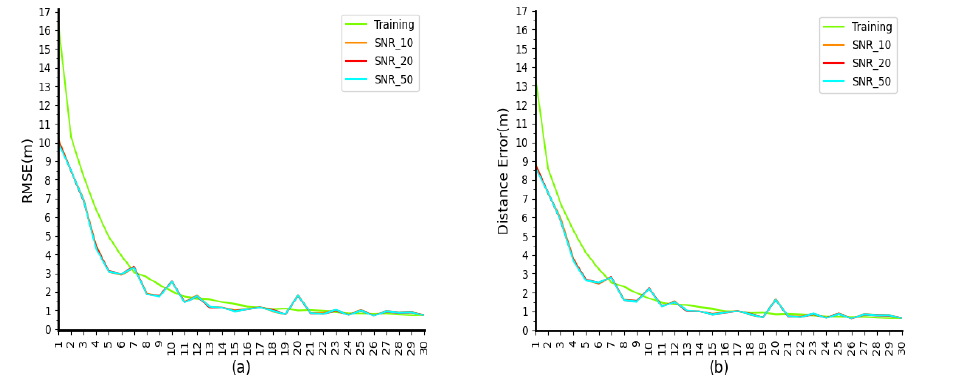
Figure 9. Performances of different SNRs of the first 30 training epochs: ( a ) in terms of RMSE; ( b ) in terms of MeanError.